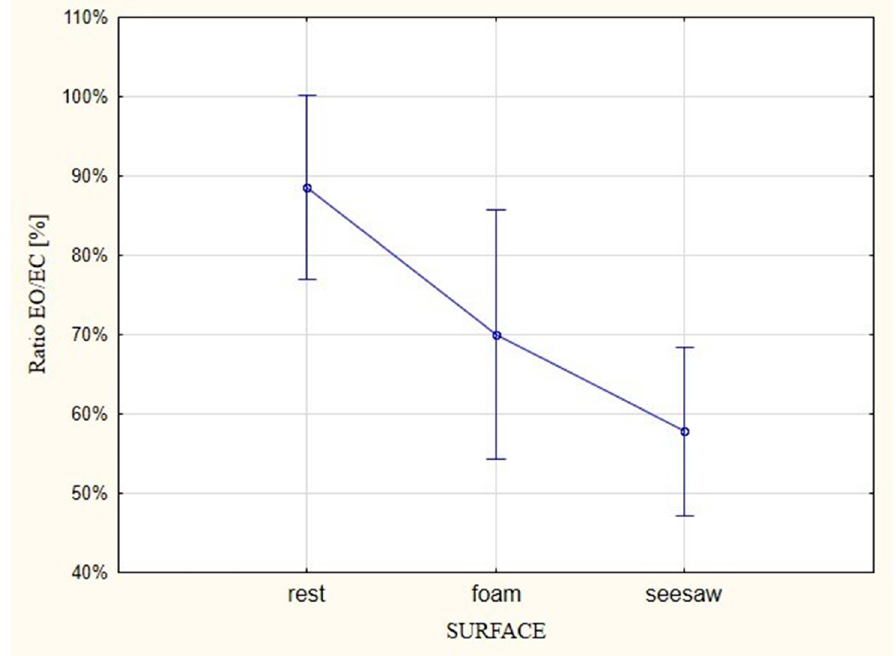
Figure 3. EMG ratios (ratios of synergistic and antagonistic muscles of the ankle joint) for tests performed with EO versus EC on different types of surfaces.